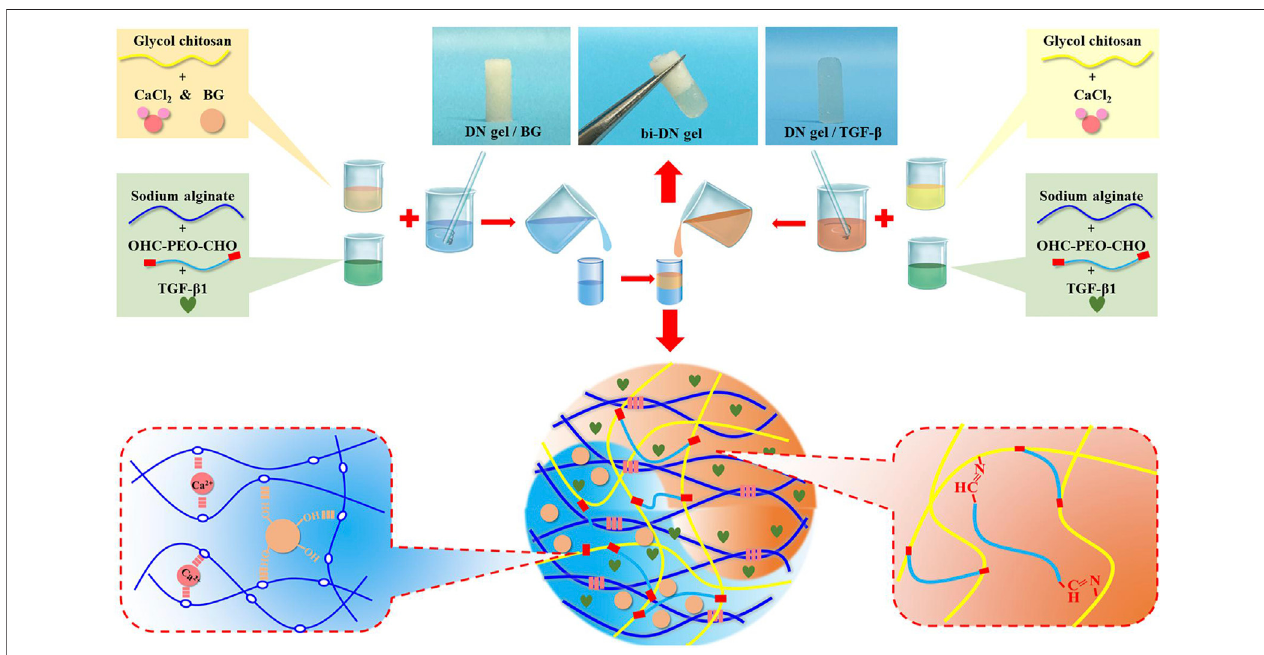
FIGURE 4 | Schematic illustration of the composite bioinks (bi-DN gel). DN, double-network; CaCl 2 , calcium chloride; BG, bioactive glass; TGF, transforming growth factors; Reproduced with permission (Liu et al., 2020). Copyright: © 2020 Liu, Zhao, Zhu, Gao, Ye, Zhou, Qiu, Wang, Tian and,